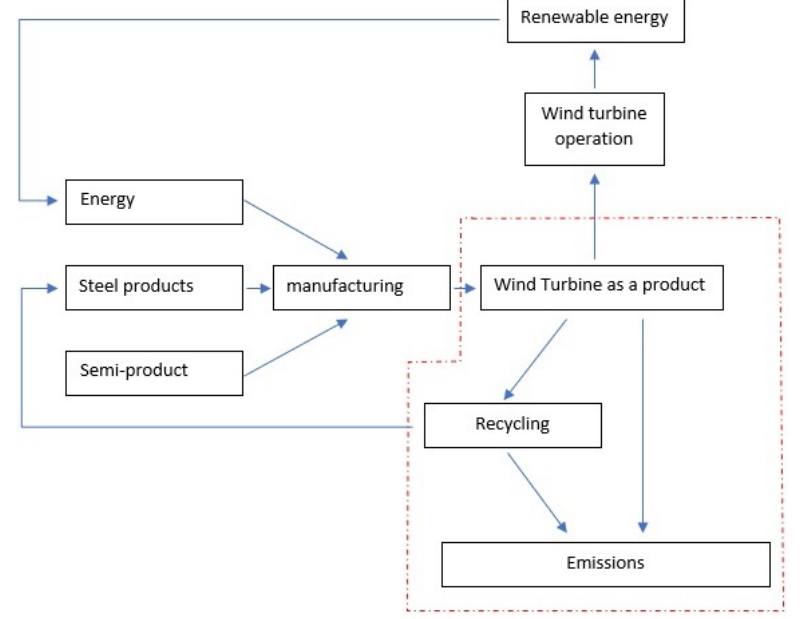
Figure 1. Flow diagram of used methodology with system